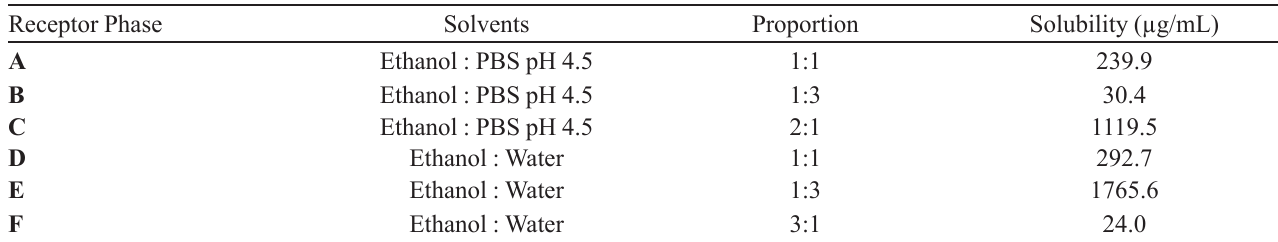
TABLE IV - Solubility of mometasone furoate in different solvents. Receptor